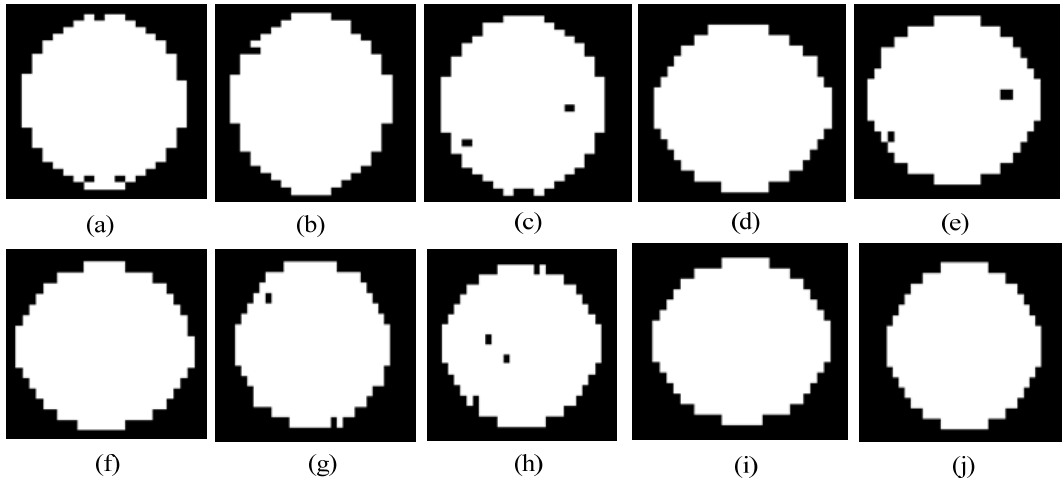
Figure 22. The results of the die region detection corresponding to the images shown in Figure 21a–j.